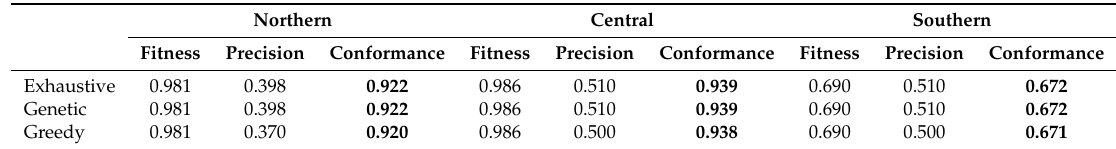
Table 1. Comparison of the proposed strategies for the three universities. Northern Central